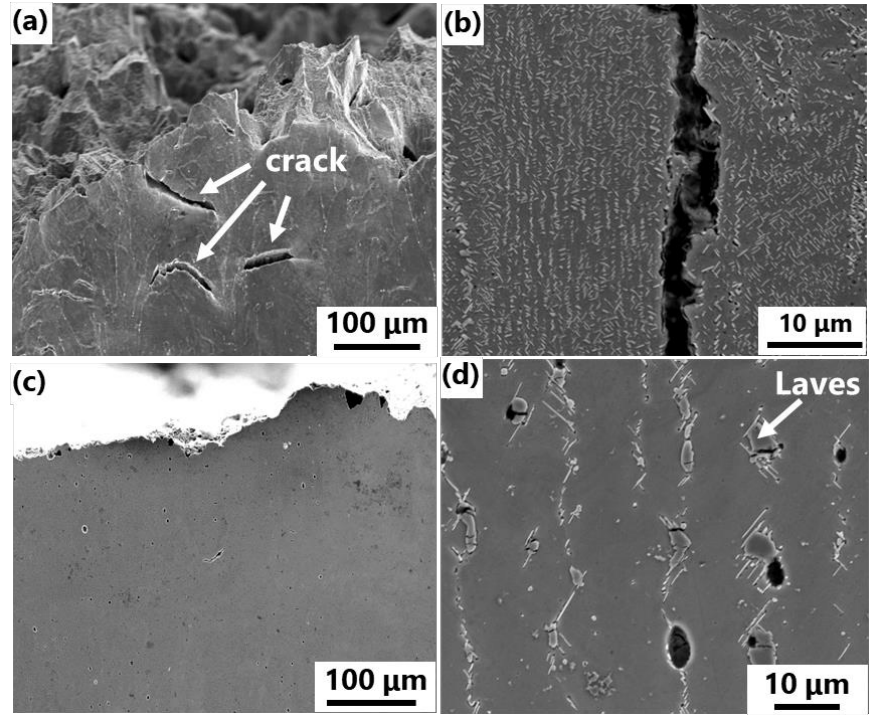
Figure 9. Microstructure after creep test: ( a,b ) Ar-SLM; and ( c,d ) V-SLM specimens.